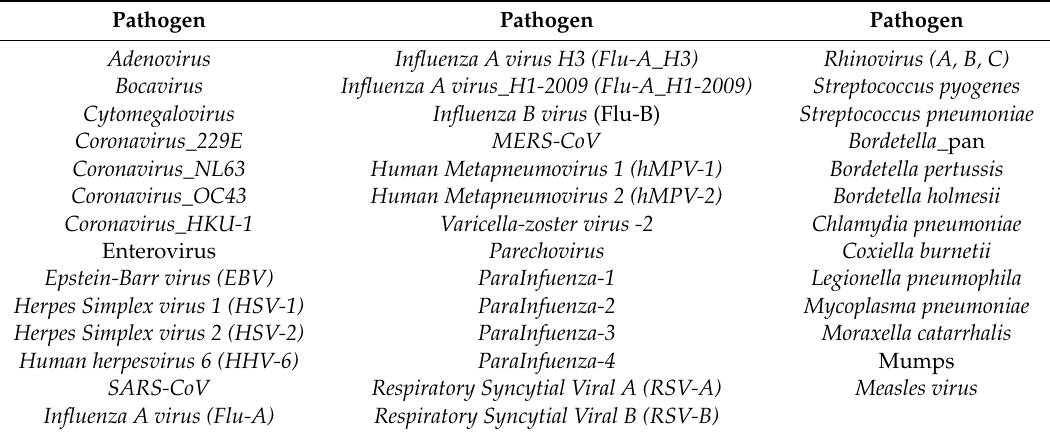
Table 4. Respiratory pathogens detection